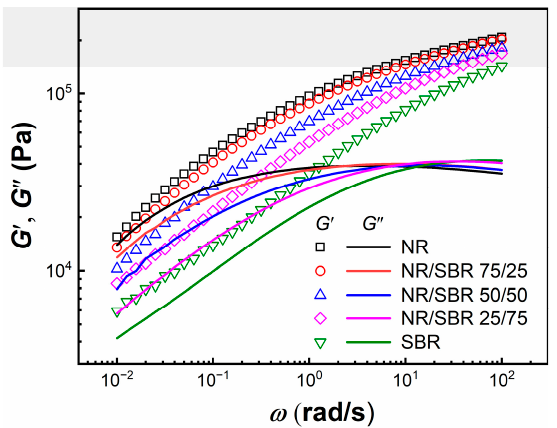
Figure 4. Storage moduli G ′ (open symbols) and loss moduli G ′′ (solid lines) as a function of frequency ω at γ = 0.5% and 100 °C for the NR, SBR, and NR/SBR blends.